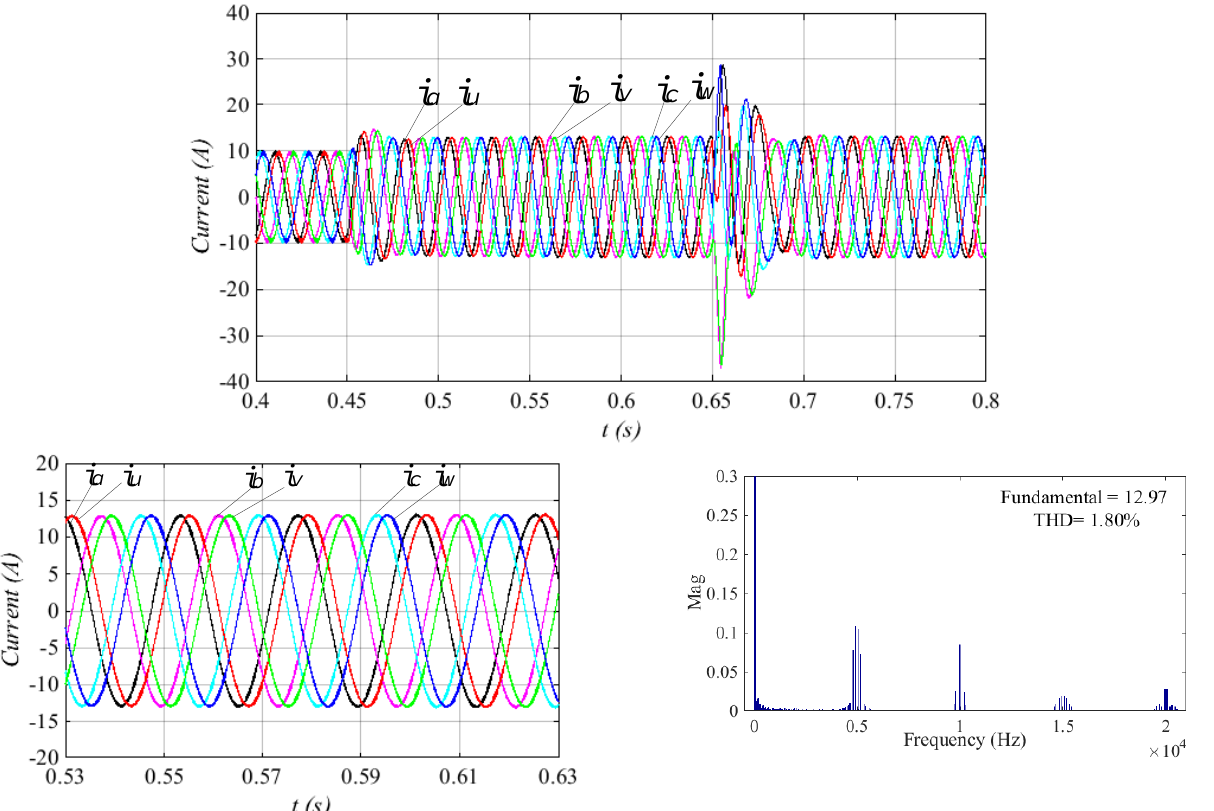
Figure 15. Simulation results of the six-phase current and the FFT analysis of the steady state current i a for DZIPWM.